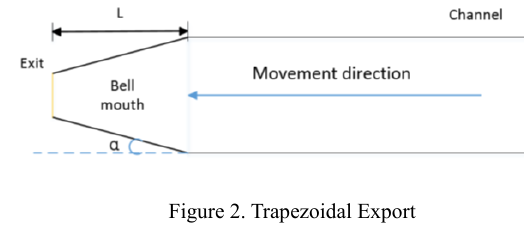
Figure 2. Trapezoidal Export